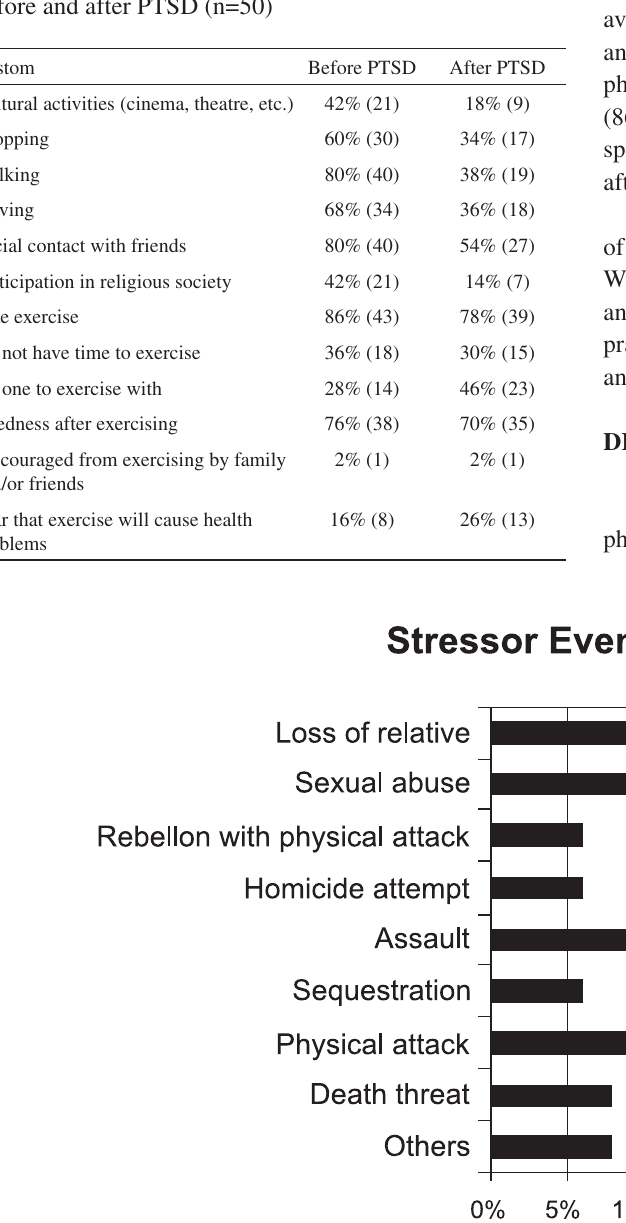
Table 2 - Leisure time activities and physical activities habits before and after PTSD